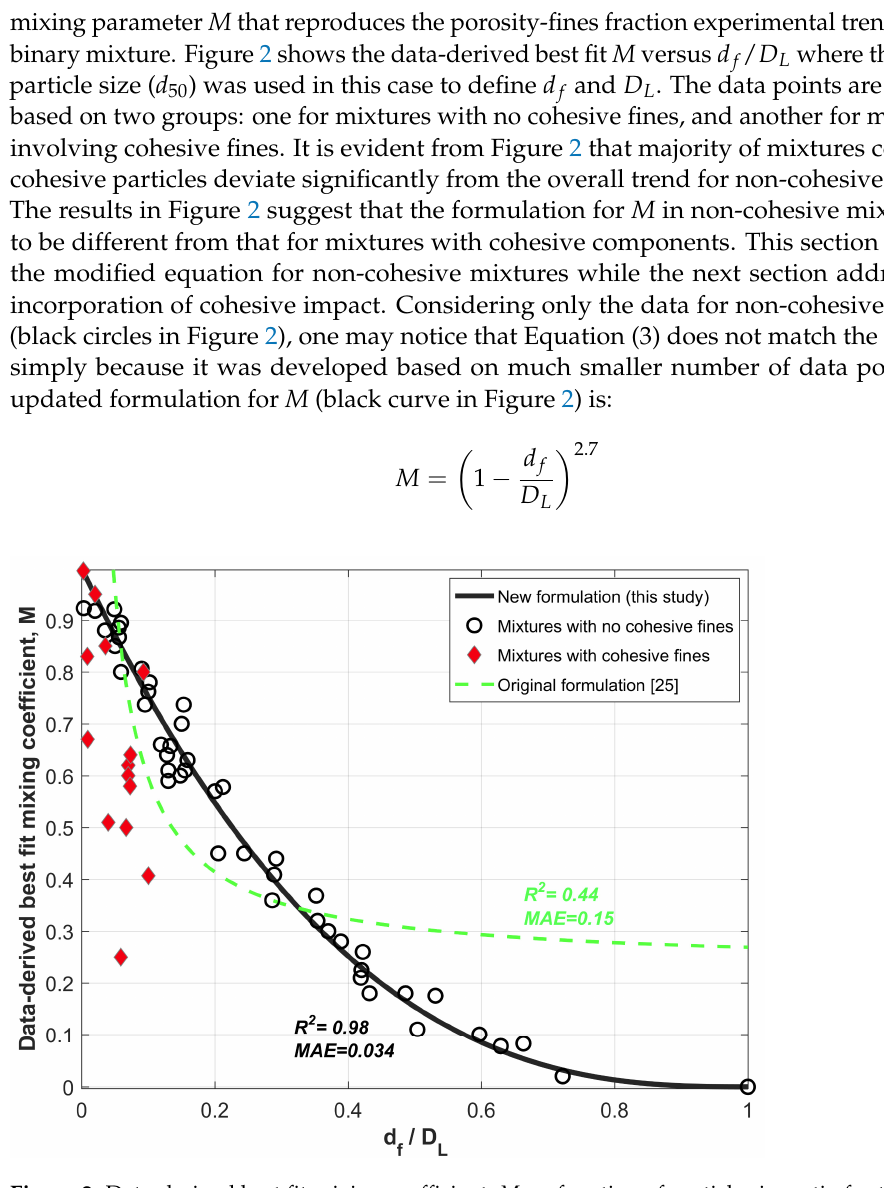
Figure 2. Data-derived best fit mixing coefficient, M, as function of particle size ratio for two groups of binary mixtures: non-cohesive mixed soil in black circles (data from [6,17,23,25,30,40–46]) and mixtures with cohesive fines component shown in red diamond (data from [7,30,32,47–55]). The predictions of M based on original formulation (Equation (3)) and the modified one. Equation (6) does not only fit the data better than Equation (3), but it also honors the two boundary conditions of ideal mixing ( M ≈ 1 when (cid:1856) (cid:3033) /(cid:1830) (cid:3013) approaches zero) and no- mixing ( M = 0 when (cid:1856) (cid:3033) /(cid:1830) (cid:3013) = 1). The use of Equation (6) to estimate M resulted in high correlation coefficient (Figure 2; R 2 = 0.98) and reduced the mean absolute error ( MAE ) by 77% compared to the use of Equation (3) reported originally by [25]. Figure 3 shows ex- amples for the prediction of porosity or void ratio of binary mixed soils as function of fines fraction. The current modified model (Equations (1), (2) and (6)) provided better predic- tion of porosity/void ratio compared to the original model (Equations (1)–(3)), especially